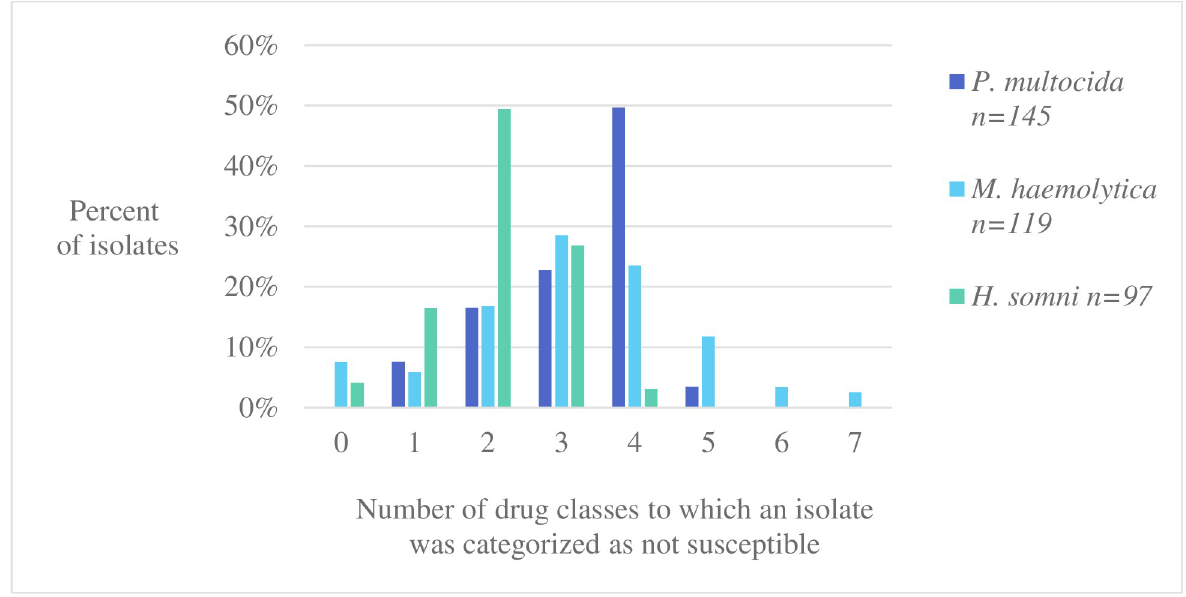
Fig 2. Number of antimicrobial drug classes to which each respiratory isolate ( P . multocida , M . haemolytica and H . somni ) was classified as not susceptible (resistant or intermediate). The distribution of isolates by number of classes to which they were categorized as not susceptible is shown as percent of total isolates per species. Seven drug classes were represented among antimicrobial drugs with applicable breakpoints. P . multocida (n = 145), M . haemolytica (n = 119), H . somni (n = 97).